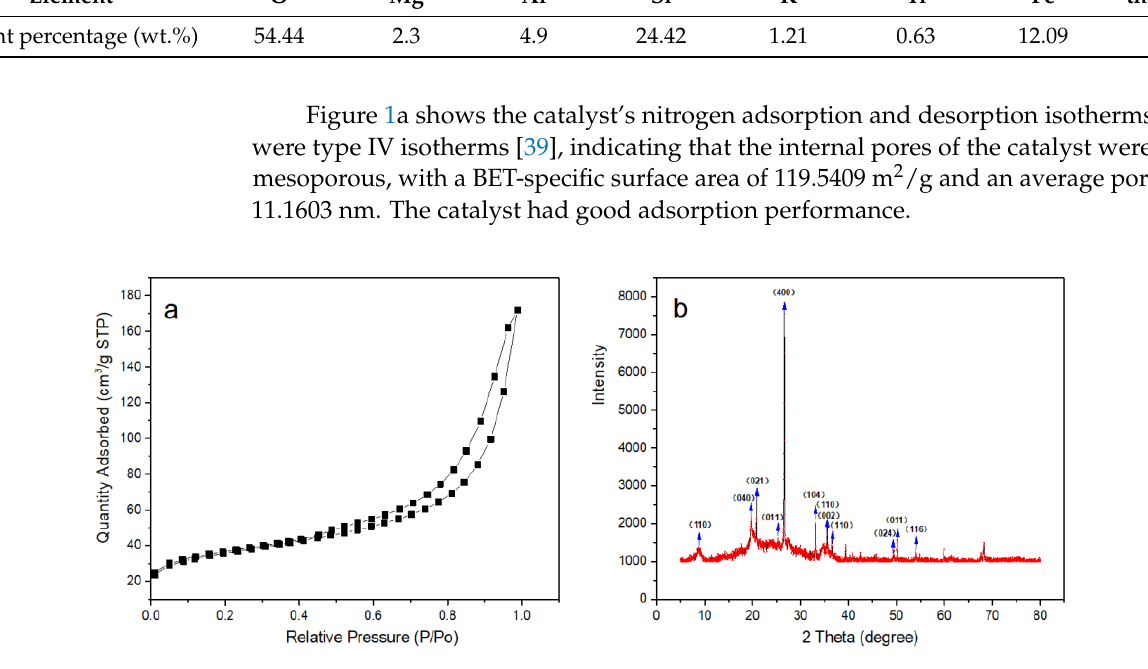
Figure 2. SEM image of catalyst before ( a ) and after ( b ) reaction (×40,000). 2.2. Influence of Reaction Conditions on Degradation Performance 2.2.1. Influence of Different Reaction Systems on RhB Degradation It can be seen from Figure 3a,b that in different reaction systems, the degradation and mineralization effects of RhB were not ideal when a hydrogen peroxide solution was added only at 35 °C and pH 3. After 240 min, the removal rate of RhB and the TOC min- eralization rate were only 5.98% and 0.92%, respectively. When only a granular catalyst was added to the reaction solution without H 2 O 2 , the concentration of RhB and TOC de- creased in the same trend, indicating that the reduced RhB concentration was only ad- sorbed by the granular catalyst, no molecular ring-opening or degradation mineralization occurred, and the adsorption amount reached 39.61% at 240 min. When 0.5 mg/L Fe 3+ and 196 mmol/L H 2 O 2 solutions were added to the reaction solution to form a homogeneous Fenton system, the homogeneous Fenton reaction caused by a small amount of dissolved Fe 3+ insignificantly contributed to the catalytic degradation of RhB in the system regarding the RhB removal rate and mineralization effect. Therefore, it can be seen that the degra- dation of dye-RhB by an iron-loaded attapulgite granular catalyst was mainly contributed to by a heterogeneous Fenton reaction, which conformed to the heterogeneous surface